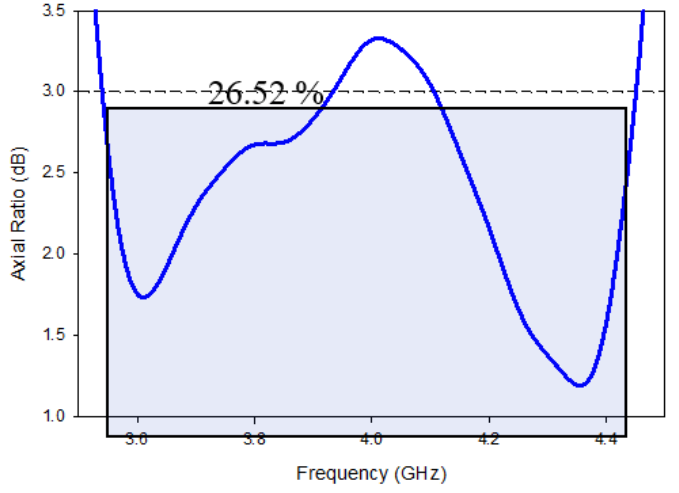
Figure 7. Axial ratio bandwidth of Design-2.